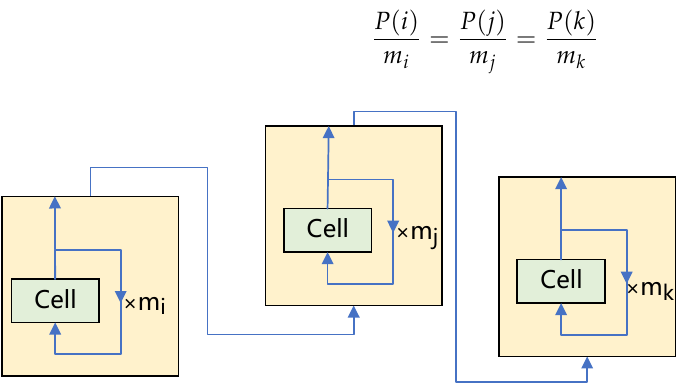
Figure 7. Distributed deployment of an RNN in AIBot.